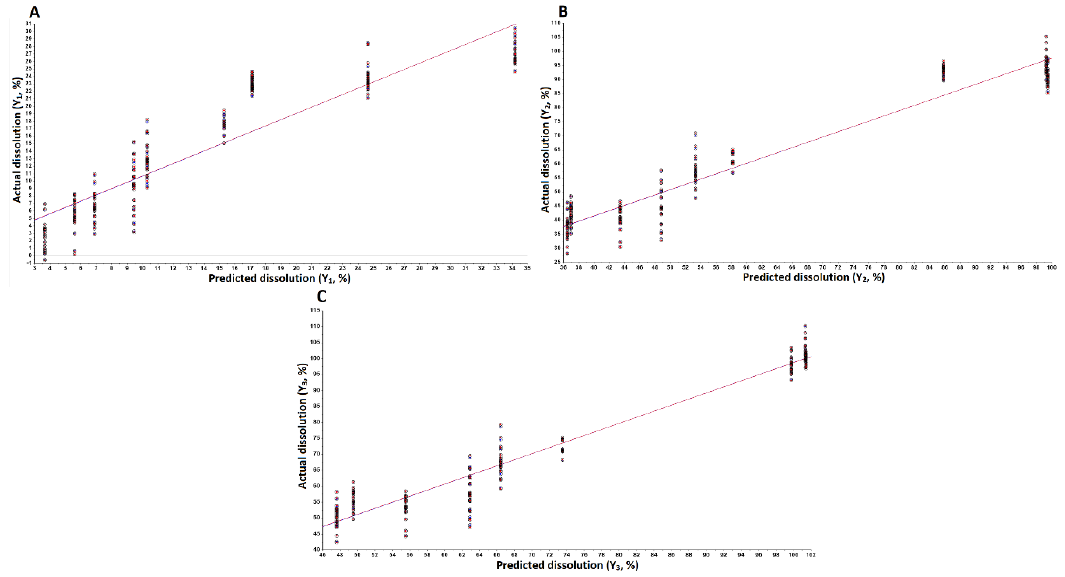
Figure 9. Chemometric models predicted and actual values curve of ( A ) Y 1 , ( B ) Y 2 and ( C ) Y 3 tablets coated with CAB 171-15/C-A-P blend.